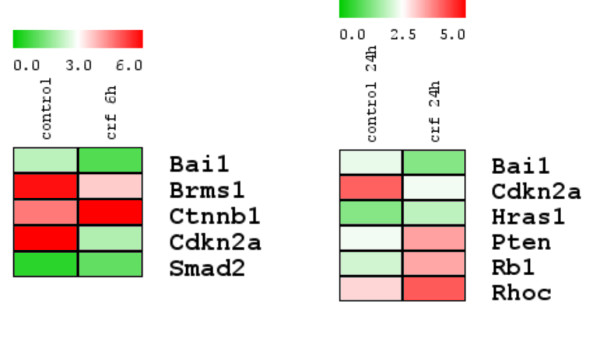
Effects of CRF on the expression of molecules involved in tumor growth and metastasis. Gene-specific oligo microarrays for 113 genes known to be involved in tumor growth and metastasis were performed as described in Materials and methods. Effect of CRF on the expression of these molecules in 4T1 cells was analyzed. Mean expression of each gene was transformed into color intensity using the program TIGR MultiExperiment Viewer V4.5.1. The minimal value (green) and the maximum (red) were considered the limits (as noticed in bar above). The figure shows the molecules which expression was affected by CRF after 6 or 24 h of treatment: Bai1, Brain-specific angiogenesis inhibitor 1; Brms1, Breast cancer metastasis-suppressor 1; Ctnnb1, β-Catenin; Cdkn2a, Cyclin-dependent kinase inhibitor 2A; Smad2, MAD homolog 2; Hras1, Harvey rat sarcoma virus oncogene 1; Pten, Phosphatase and tensin homolog; Rb1, Retinoblastoma 1; Rhoc, Ras homolog gene family, member C.